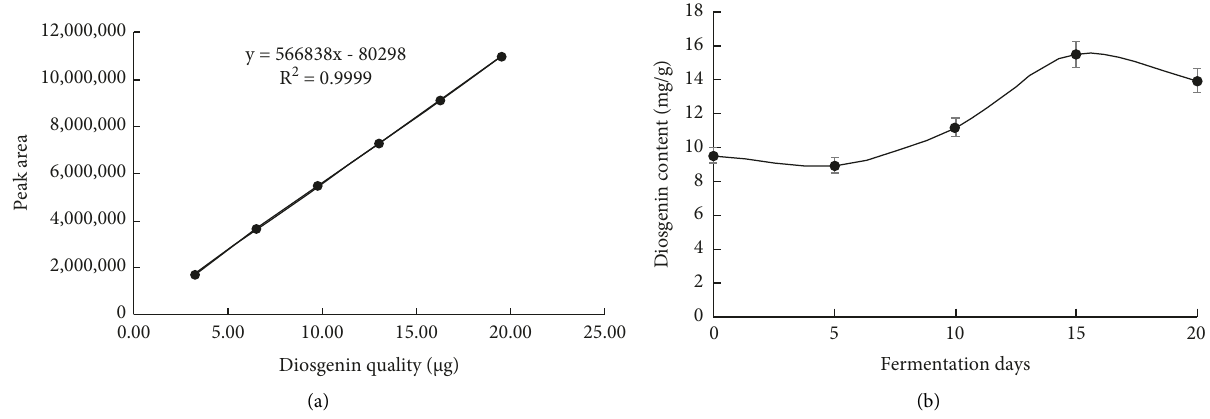
Figure 1: (a) Standard curve of diosgenin and (b) variation curve of diosgenin content on different fermentation